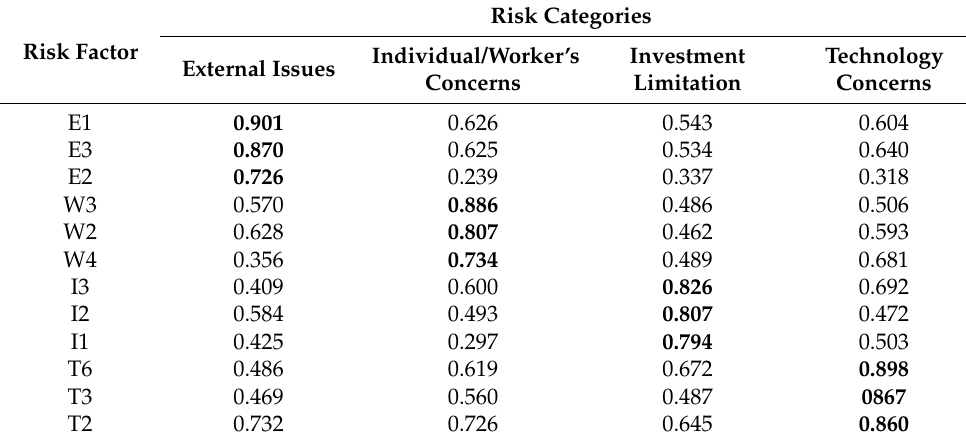
Table 7. Factor cross-loadings of the risk categories.